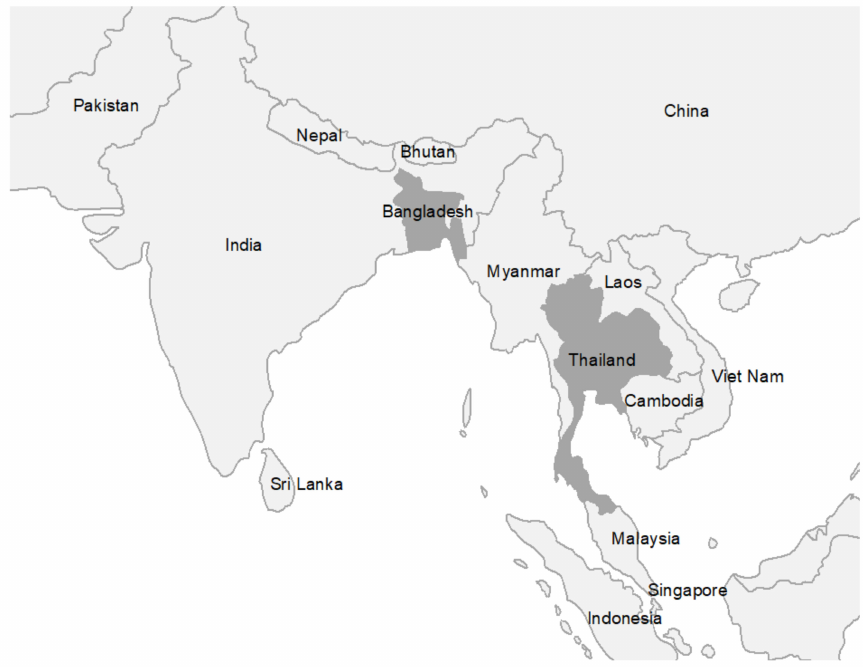
Figure 1. Locations of chikungunya virus (CHIKVs) collection in the present study. Bangladesh and Thailand, where CHIKV sera were collected, are indicated in the dark grey shade